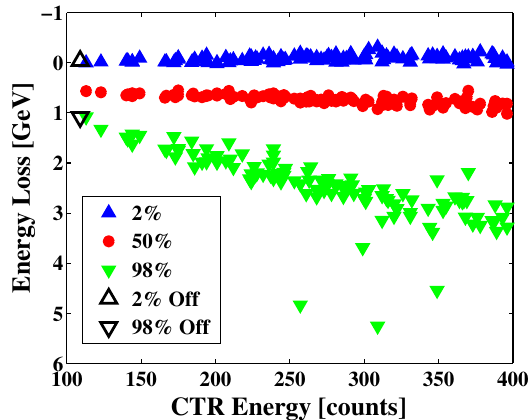
FIG. 10. (Color) Changing bunch length (NO)—Distribution of the 2%, 50%, and 98% charge levels as a function of increasing CTR energy or decreasing bunch